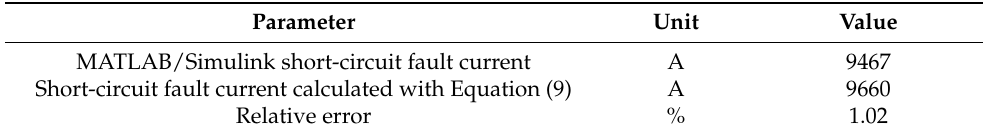
Table 7. Short-circuit fault current